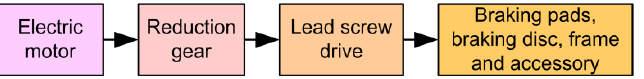
Figure 5. Schematic structure of developed electromechanical brake.